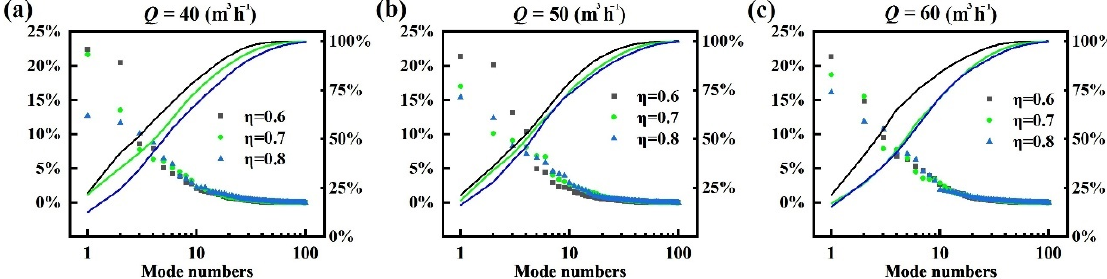
Figure 4. Turbulent energy contributions of each mode and the cumulative contribution: ( a ) the contribution curves at the flow Q = 40 m 3 h − 1 ; ( b ) the contribution curves at the flow Q = 50 m 3 h − 1 ; ( c ) the contribution curves at the flow Q = 60 m 3 h − 1 . The turbulent energy contributions are the scatters and correspond to the left axis; the cumulative contributions are the curves and correspond to the right axis.